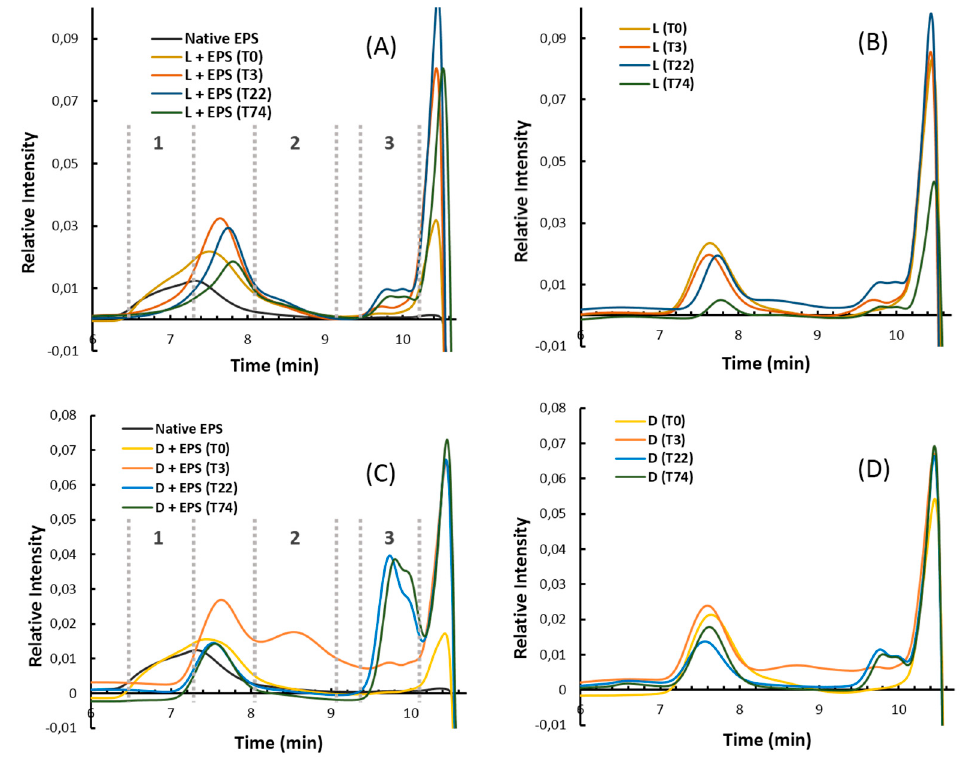
Figure 3. High pressure size exclusion chromatography (HPSEC) profiles (refractive index (RI) detection) of the native GY785 EPS incubated with lysate, L + EPS ( A ), lysate, L ( B ), EPS incubated with insoluble cell debris, D + EPS ( C ) and cell debris, D ( D ) in Tris HCl buffer for different incubation times (T) 0, 3, 22 and 74 h.